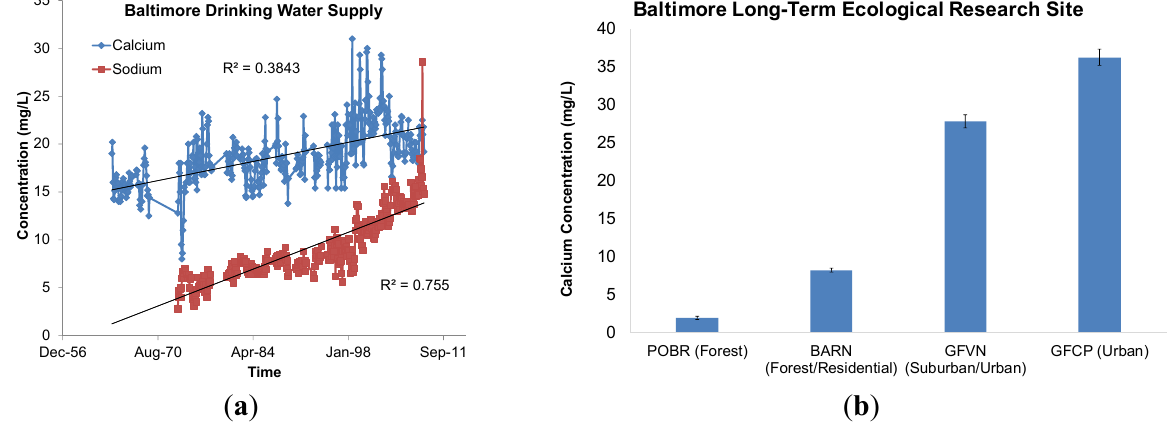
Figure 3. Long-term increasing trends in calcium and sodium concentrations in the drinking water supply of Baltimore, MD, USA ( a ) (data courtesy of Bill Stack, Baltimore City Department of Public Works). Increased seasonal mean calcium concentrations in streams across a gradient of urbanization at the Baltimore Long-Term Ecological Research (LTER) site during 2009 (POBR is a forested stream, BARN is a stream draining forest/residential land use, GFVN is a stream draining suburban/urban land use, and GFCP drains urban land use); error bars denote standard error ( b ).